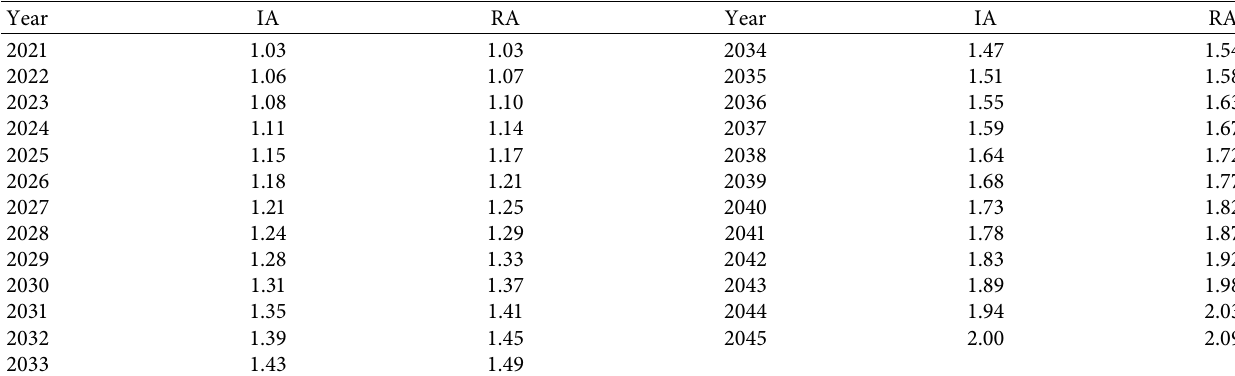
Table 4: Annual discount and inflation operator.